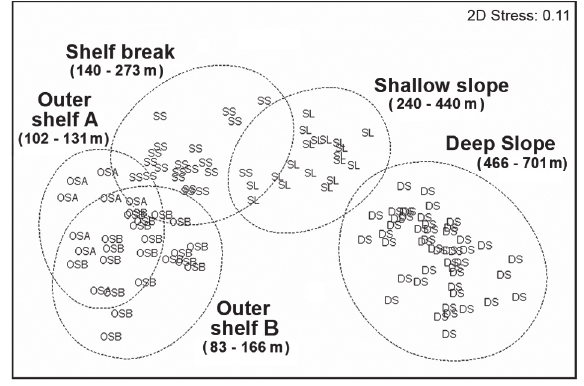
Fig 2. – Non-metric multidimensional scaling (nMDS) plot for the sampling stations for all the three years based on the biomass data. The ovals show the groups generated by cluster analysis. OSA, Outer Shelf A; OSB, Outer Shelf B; SS, Shelf Break; SL, Shallow Slope; DS, Deep